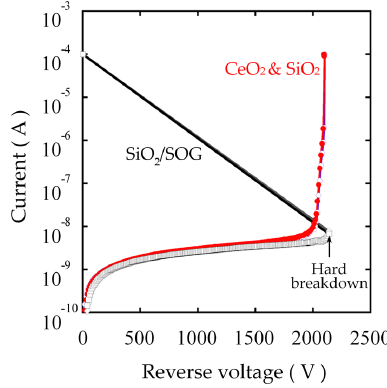
Figure 7. Reverse bias characteristics of diodes.